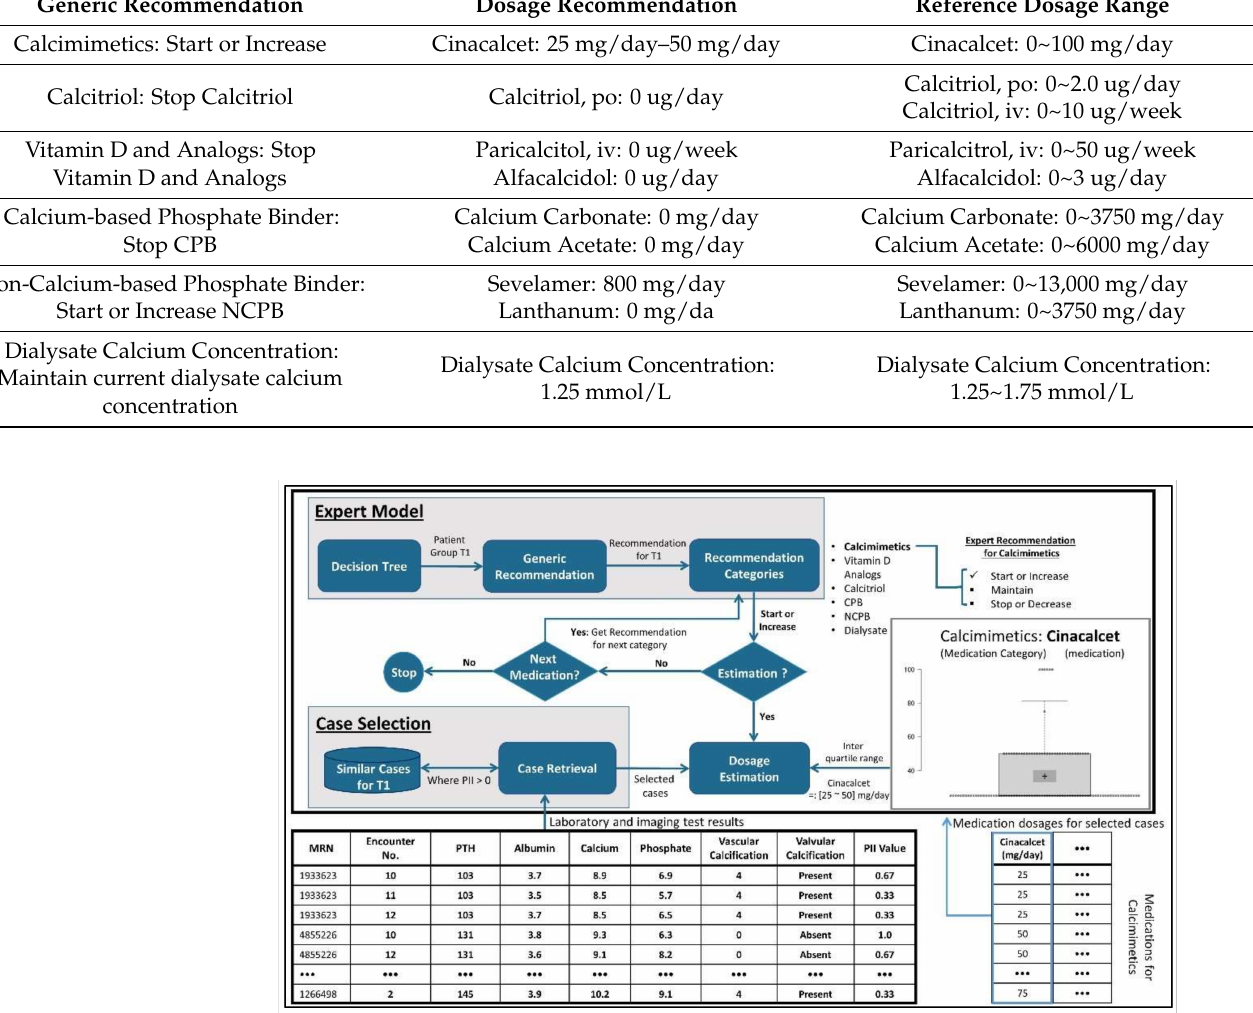
Figure 9. Medication dosage selection and dosage adjustment based on domain knowledge and interquartile range